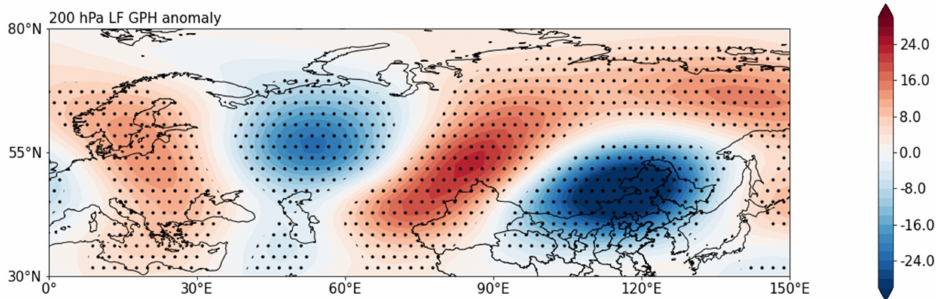
Figure 8. Composited 200 hPa low-frequency GPH anomalies of LFEHTs from 5 to 10 days before their occurrences (the dotted areas are significant at a 95% confidence